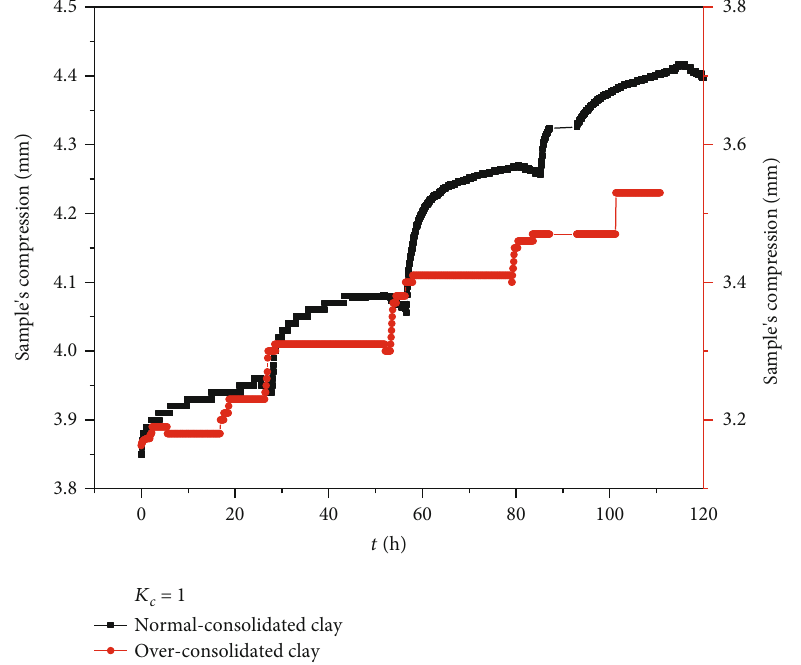
Figure 18: The curve of compression with time considering the in fl uence of stress